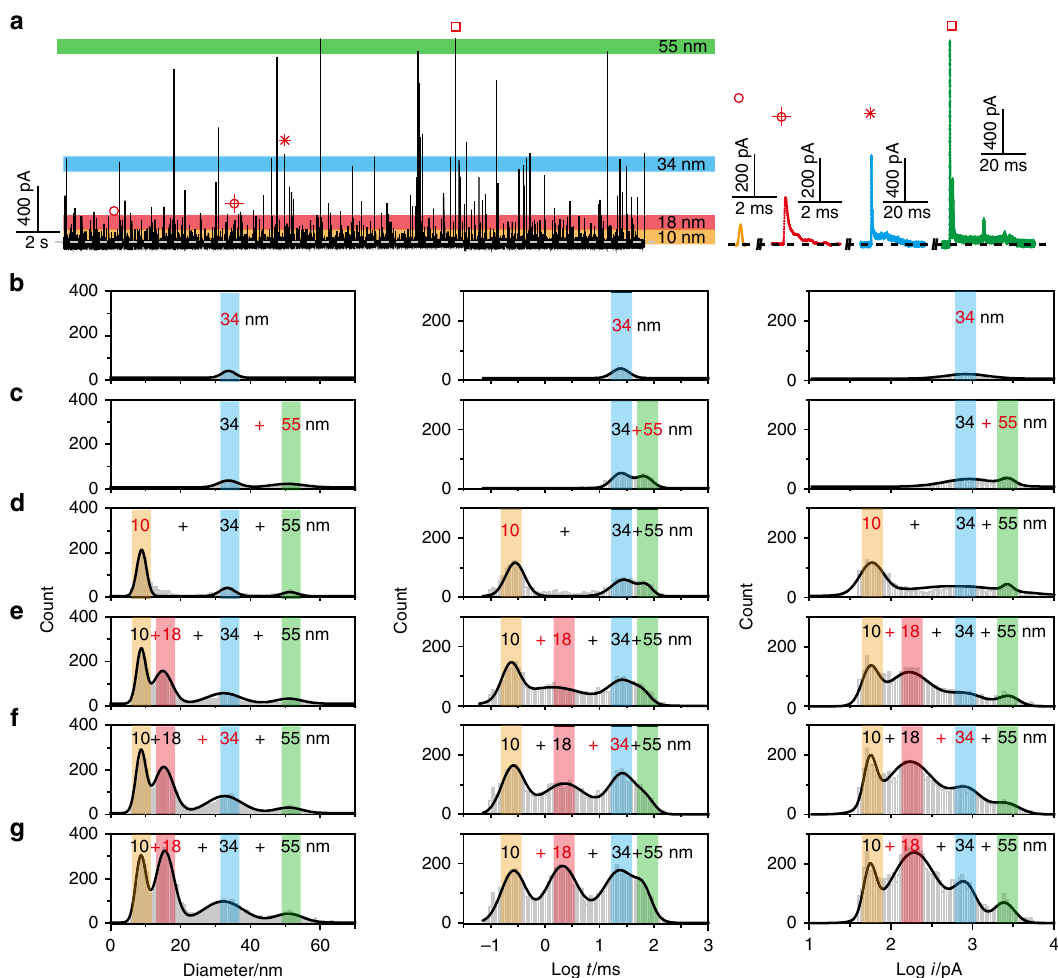
Fig. 4 In situ electrochemical size measurement of different sized AgNPs mixture. a Continuous chronoamperometric curves and characteristic current traces for a mixture of AgNPs with different sizes in diameters of 10, 18, 34, 55 nm, respectively. The colored bands represent the maximum current distribution for each analyte in the AgNPs mixtures. b – g Histograms of the diameter, Log t and Log i for a mixture of AgNPs. The data were acquired from AgNPs with difference sizes, which were added in one electrochemical cell in sequence (in bold red font), at an Au UME (diameter 12.5 μ m) in 15 mM PB and 10 mM NaOH at pH = 11.4 and + 600 mV vs. Ag/AgCl wire. Source data are provided as a Source Data fi